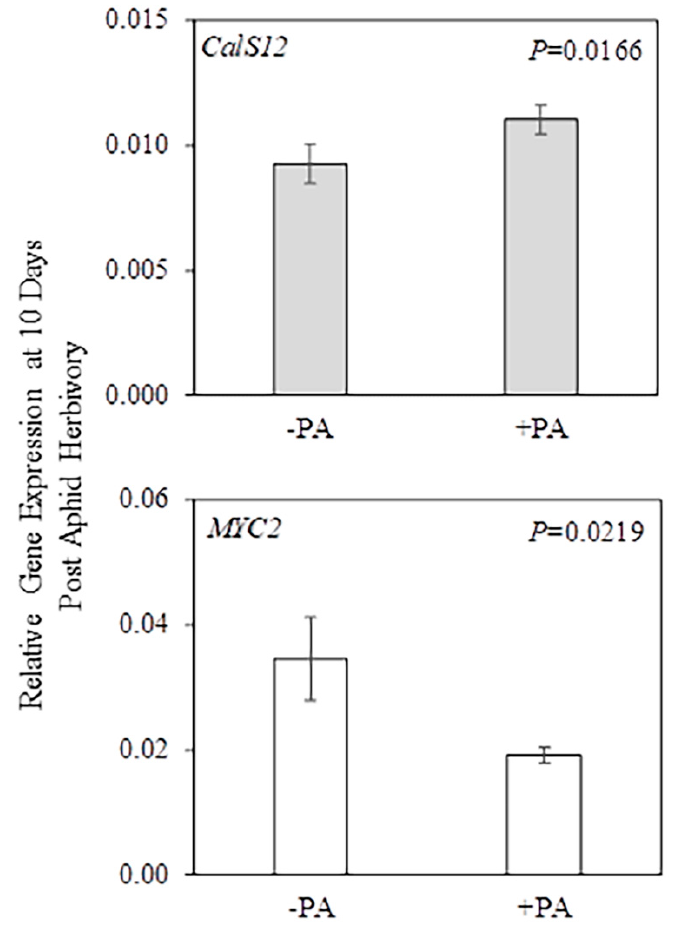
Figure 6. Relative gene expression in systemic leaf (gray bar) and roots (white bar) after 10 days of herbivory by potato aphids ( Macrosiphum euphorbiae ) on potato plants ( Solanum tuberosum ). The PA*AMF interaction was not significant in the two-factor ANOVA, but potato aphid herbivory as a main factor had a significant effect (PA p ≤ 0.05) on CalS12 and MYC2 gene expression. Values represent the mean ± SEM (n = 9 for − PA /+ PA). The p -values from Table S2 were used to generate this figure. PA = potato aphid. CalS12 = CALLOSE SYNTHASE 12; MYC2 = BASIC-HELIX-LOOP-HELIX TRANSCRIPTION FACTOR.